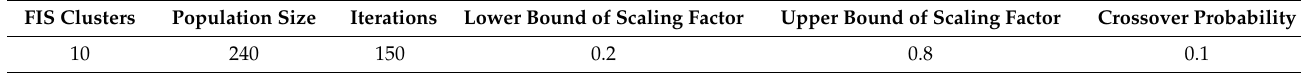
Table 8. Parameter characteristics used for DEO.